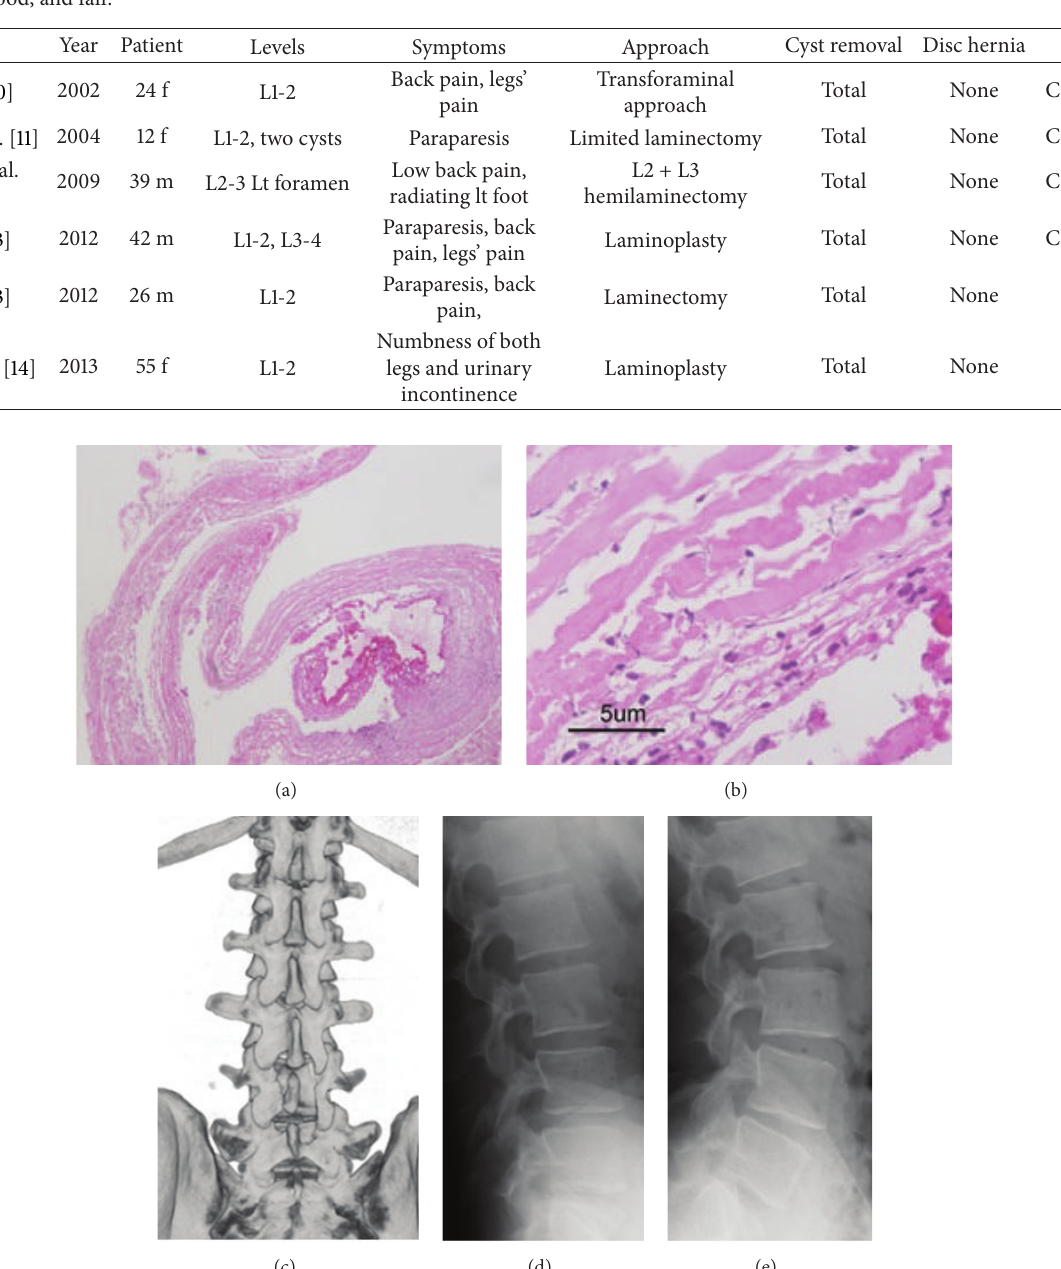
Figure 3: A section of the cyst wall ((a): hematoxylin and eosin, original magnification × 40 and (b): × 400) demonstrates thick collagenous fibers and some clusters of meningothelial cells with arachnoid dura within the cyst. Postoperative 3-dimensional CT (c) shows the right- side L4 hemilaminectomy and upper L5 laminotomy, with preservation of the facet joints. Dynamic plain radiography ((d), (e)) shows no instability or kyphotic